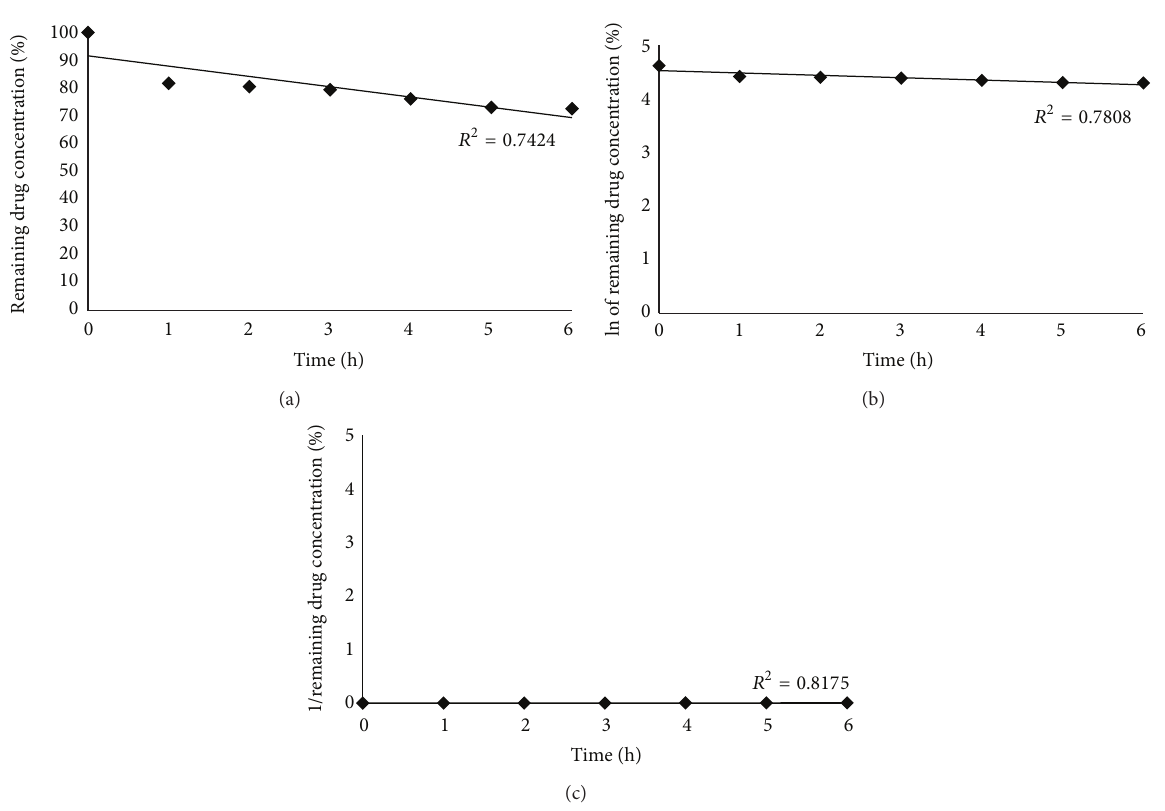
constant of 6.27 × 10 4 L/mol × h. In this case, the degradation of FA is dependent on the drug